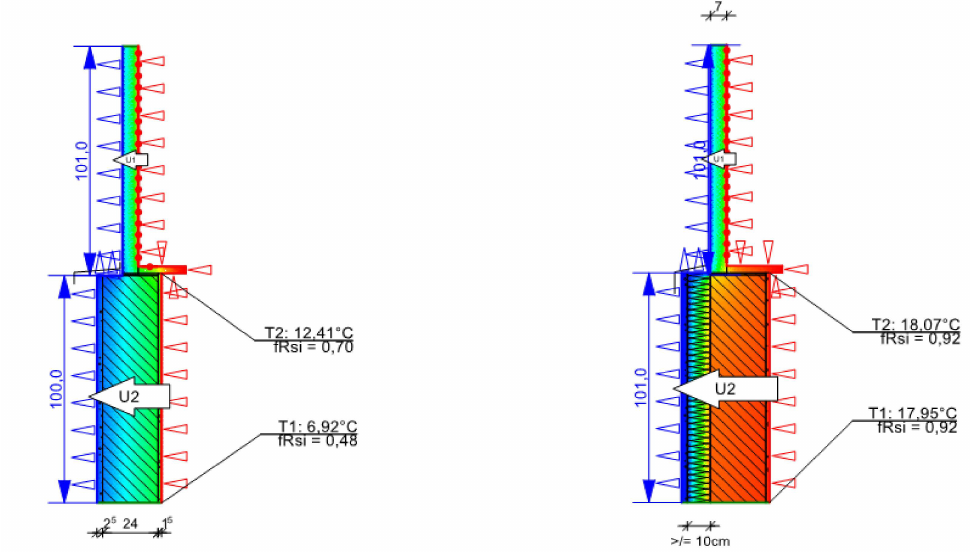
Figure A12. Before and after the thermal bridge retrofit of a window sill (created with ThermCad thermal bridge simula- tion calculator). Table A14. Retrofit components and costs of the thermal bridge retrofit of a window sill [38,39]. Pos. No.